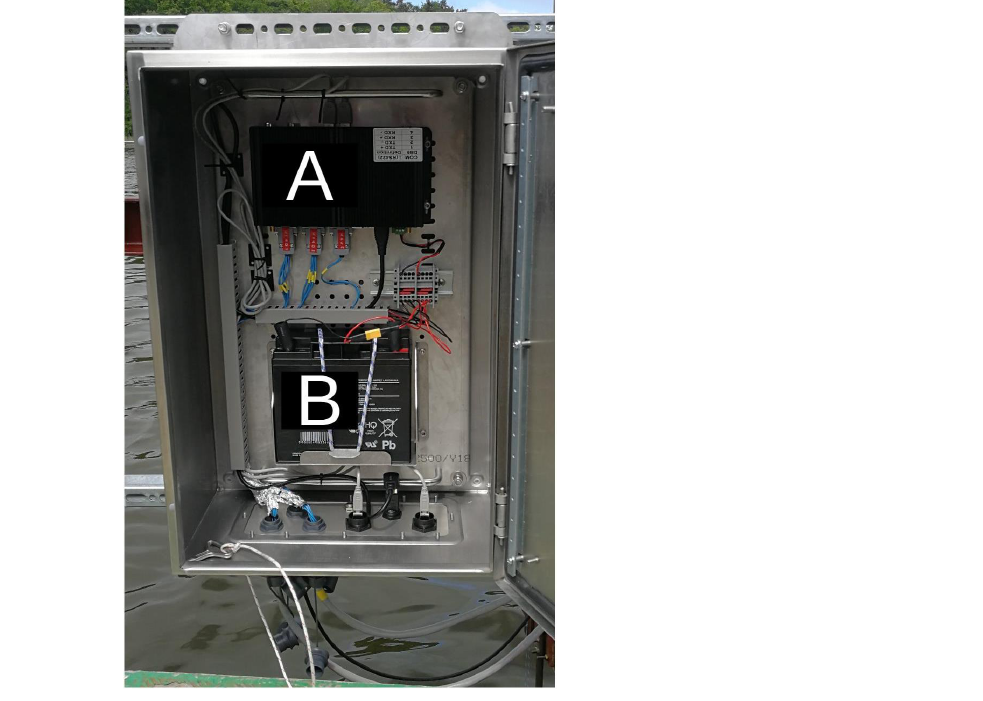
Figure 4. Measurement box arrangement: A—computer executing real-time sampling in the mea- surement system and data logging; B—12 V, 20 Ah battery.